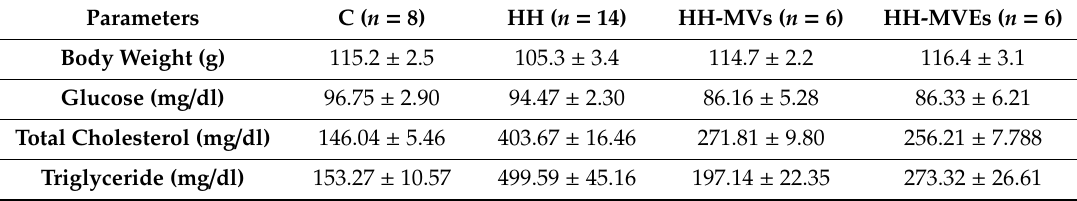
Table 2. Levels of body weight (g) and plasma glucose, total cholesterol, and triglycerides, all expressed asmg / dl, intheHH,HH-MVs, andHH-MVEsexperimentalgroupsversusCgroup. Thedatacorrespond to the analysis done at 4 months of hyperlipemic–hypertensive diet and MV / MVE treatment.